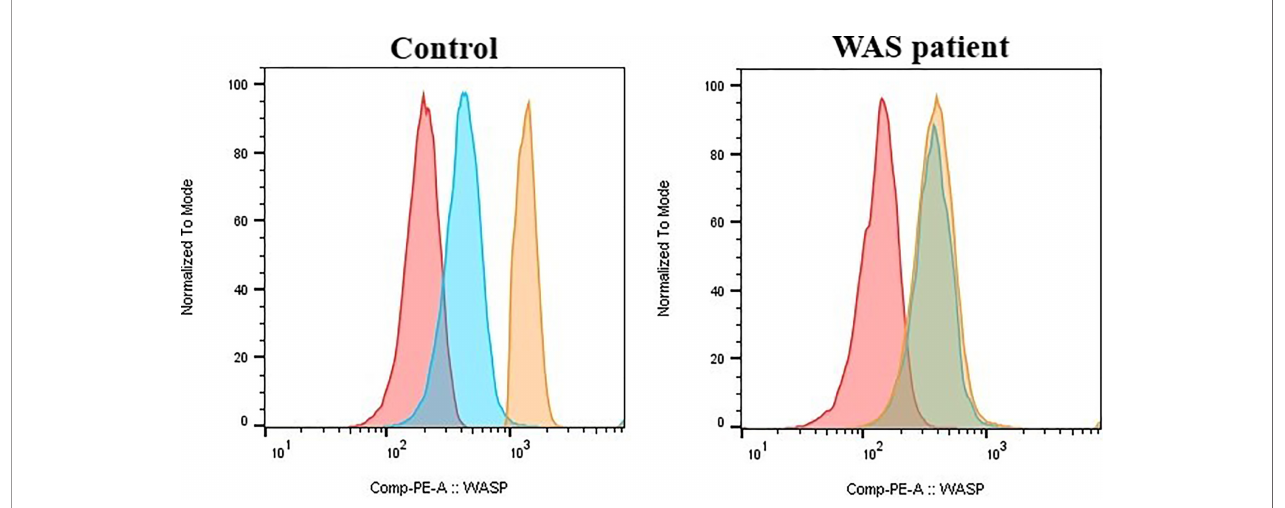
FIGURE 1 | Wiskott-Aldrich (WAS) intracellular protein expression in gated lymphocytes determined by fl ow cytometry. The median fl uorescence intensity is signi fi cantly reduced in WAS patients carrying the truncated protein. red: unstained; blue: immunoglobulin isotype control; orange: Wiskott-Aldrich